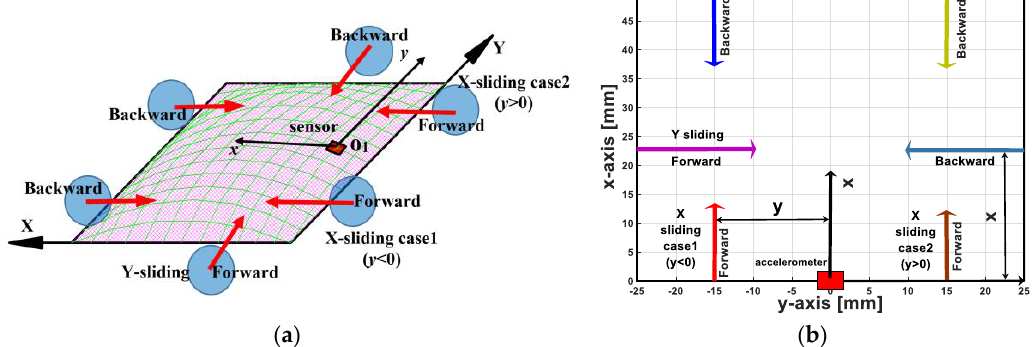
Figure 8. Schematic drawing illustrates sliding cases were conducted in experiments. ( a ) Definition of six sliding directions with both X, Y axes. ( b ) Sliding movements with various contact positions: different values of y, x for X, Y-sliding.